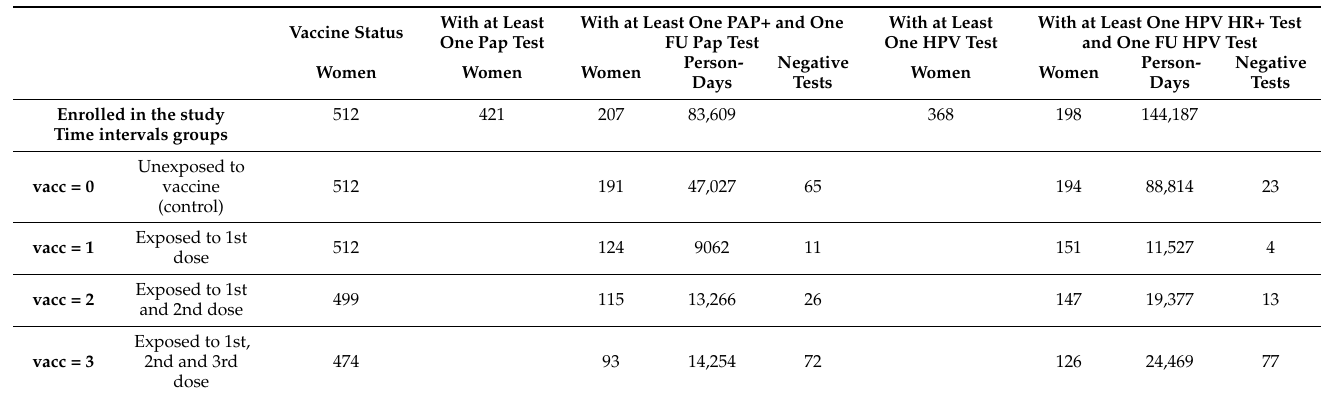
Table 1. Summary of data available for the different exposure times.